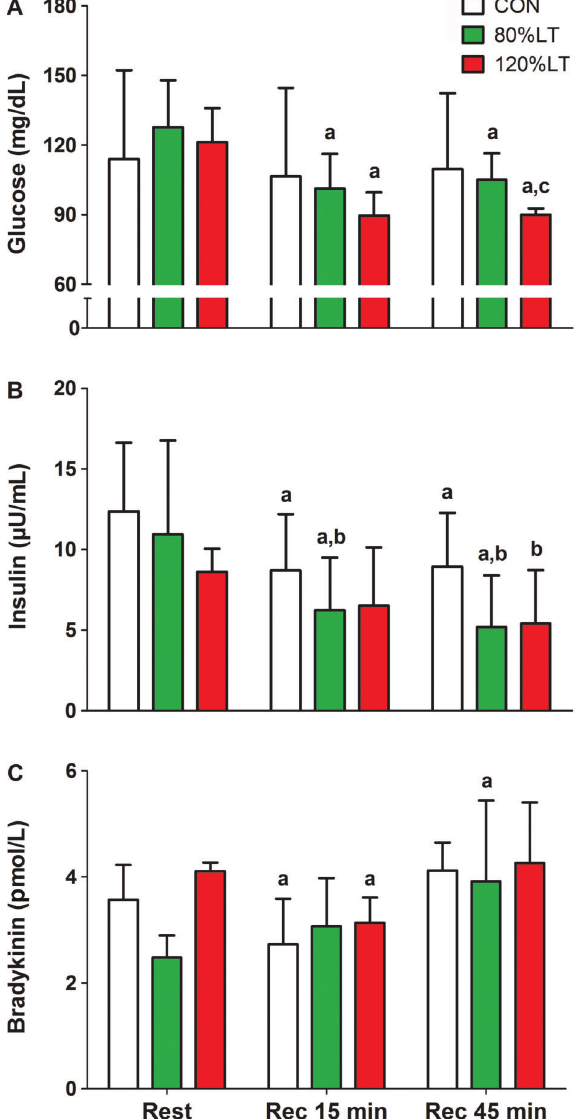
Figure 2. Blood glucose ( A ), insulin ( B ), and bradykinin ( C ) levels after the control (CON), 80%LT, and 120%LT sessions.